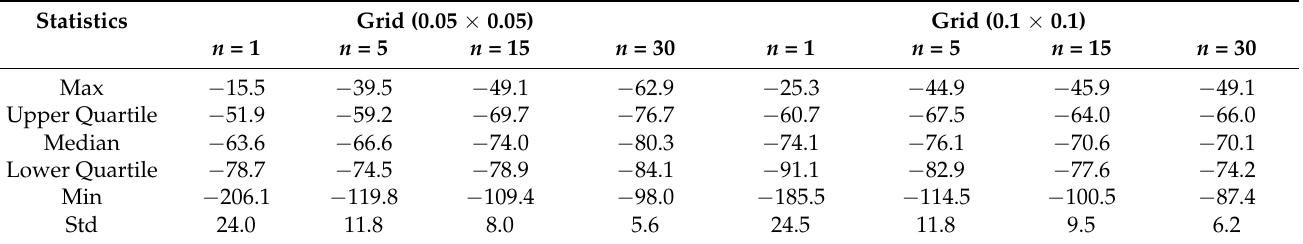
Table 1. Summary of storage depletion rate calculation statistics for the grid clustering method using 500 random data sets for scenarios using a different size grid and a different number of randomly selected points for the measured wells (values in mm 3 per year).